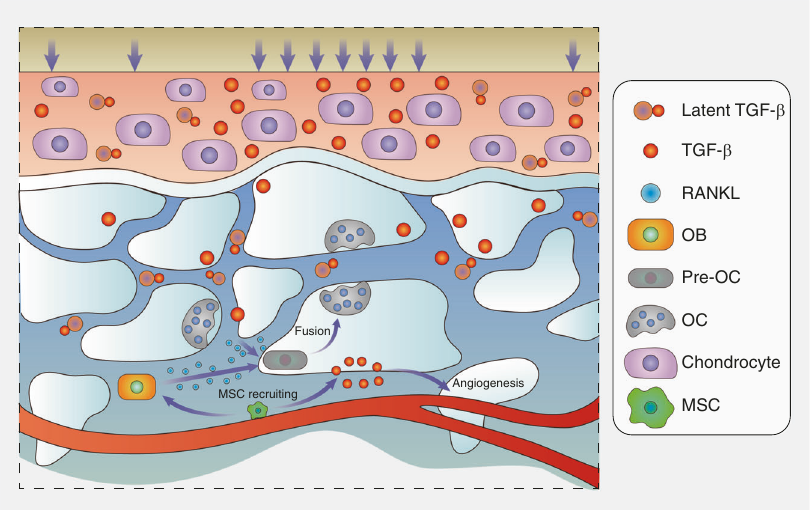
Fig. 3 TGF- β signaling in the osteochondral area in OA. Shear force breaks the spatial structure of latent TGF- β , thus releasing activated TGF- β and accelerating bone remodeling. On the other hand, overactivated osteoclasts enable TGF- β expression, recruit MSCs and facilitate angiogenesis. In turn, bone and vessel formation promote cartilage TGF- β mobilization, and the cycle